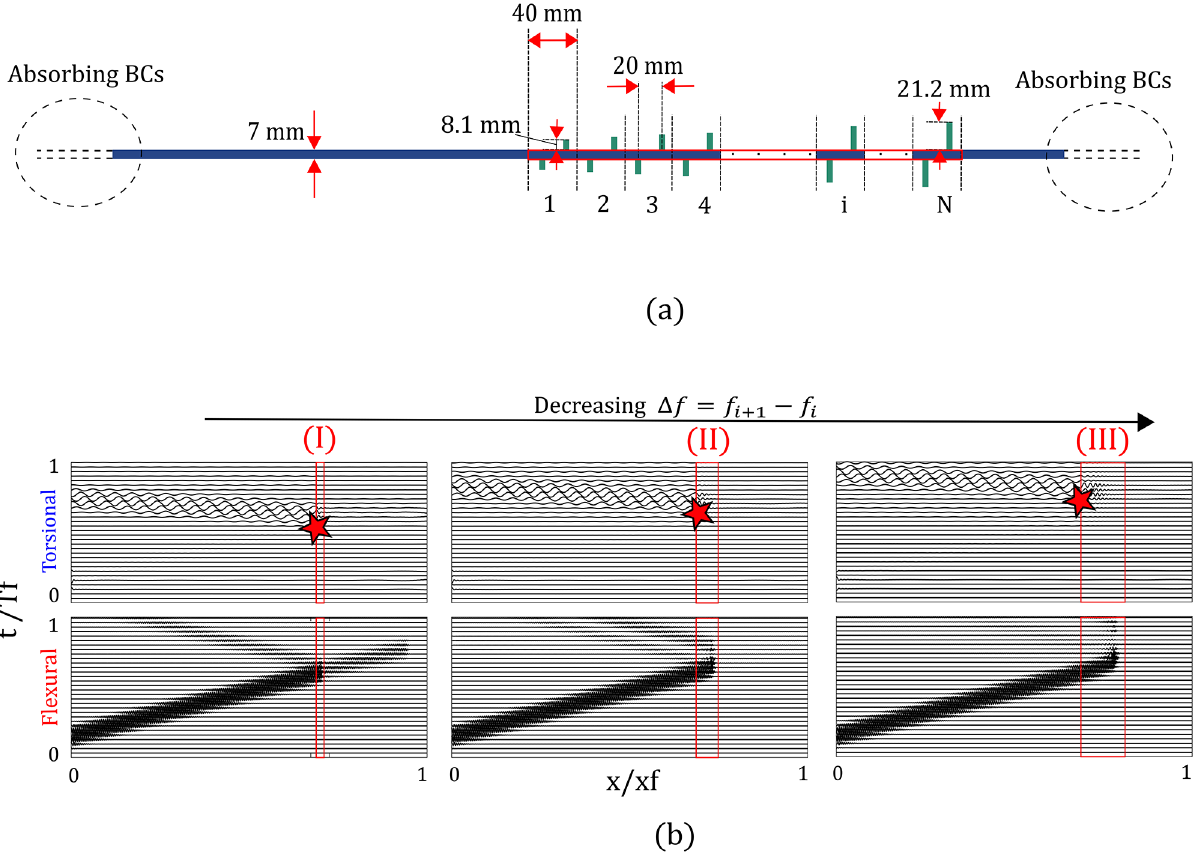
Fig. 3. (a) Graded array of asymmetric resonators with linearly increasing lengths. The spatial modi fi cation of the resonant frequency of the resonators allows to obtain locking in different spatial positions depending on frequency. (b) Space-time waterfall plots illustrating the vertical displacement ( fl exural) and the rotation (torsional) along the waveguide. The array of elements is highlighted with a red box. The numerical simulations are performed for a con fi guration with an array of (I) 9 resonators, (II) 25 resonators, and (III) 50 pairs of graded resonators. The torsional and fl exural waves represented in the diagrams are normalized by the same amplitude coef fi cient. By increasing the number of graded resonators, i.e from left to right, it is possible to move from locking to genuine rainbow